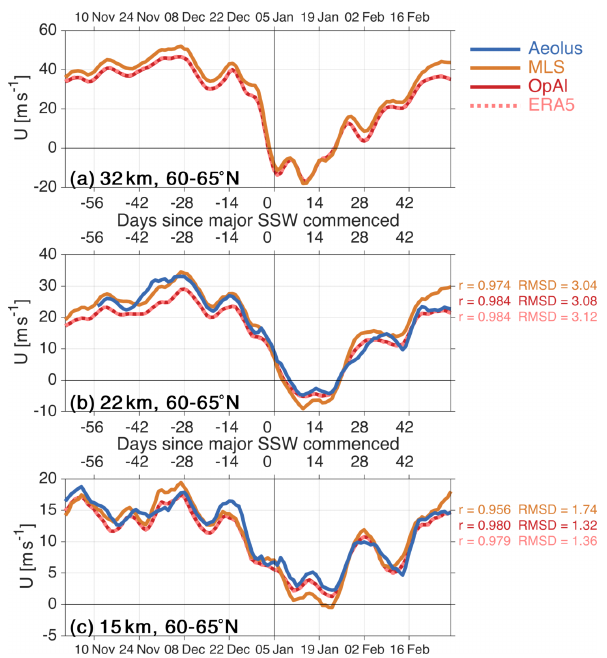
Figure 2. Daily-mean time series of zonal mean Aeolus HLOS- projected u , MLS geostrophic u , ERA5 u and ECMWF operational analysis u at (a) 32km [ ∼ 10hPa] (b) 22km and (c) 15km altitude, averaged over the 60–65 ◦ N latitude band and stationary-boxcar- smoothed 3d to account for variable spatial coverage of satellite data. For each non-Aeolus datasets, the Pearson linear correlation with root-mean-square difference (in ms − 1 ) from the Aeolus time series is shown, computed over all days for which both datasets have coverage in that time